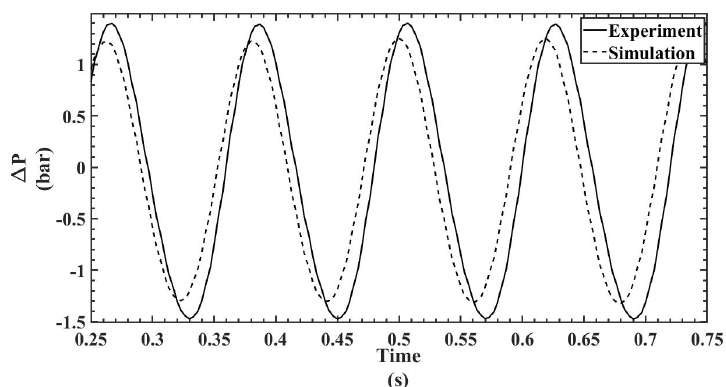
Figure 22. Temporal pressure drop for a 200 mesh regenerator at 500 RPM.